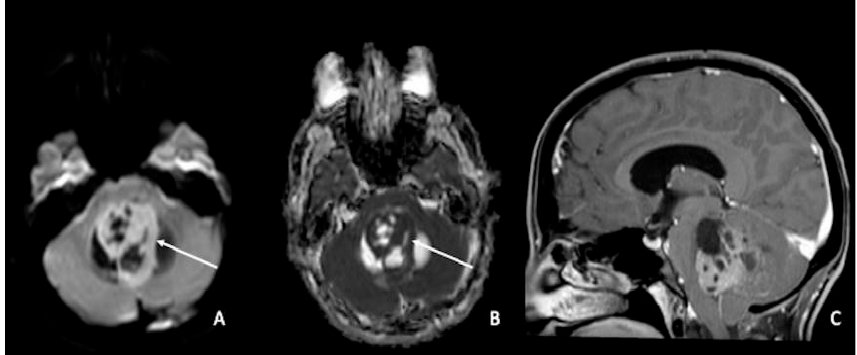
Figure 4. Medulloblastoma in a 30-year-old: ( A , C ) lesion of the posterior fossa with growth in the median line, close to the IV ventricle, characterized by inhomogeneous enhancement (arrow in ( A )), mass effect, and ( B ) low ADC values (arrow). Using ADC values and a specific cut-off, it could be possible to distinguish medulloblastoma from ependymoma or pilocytic glioma. ADC = apparent diffusion coefficient.